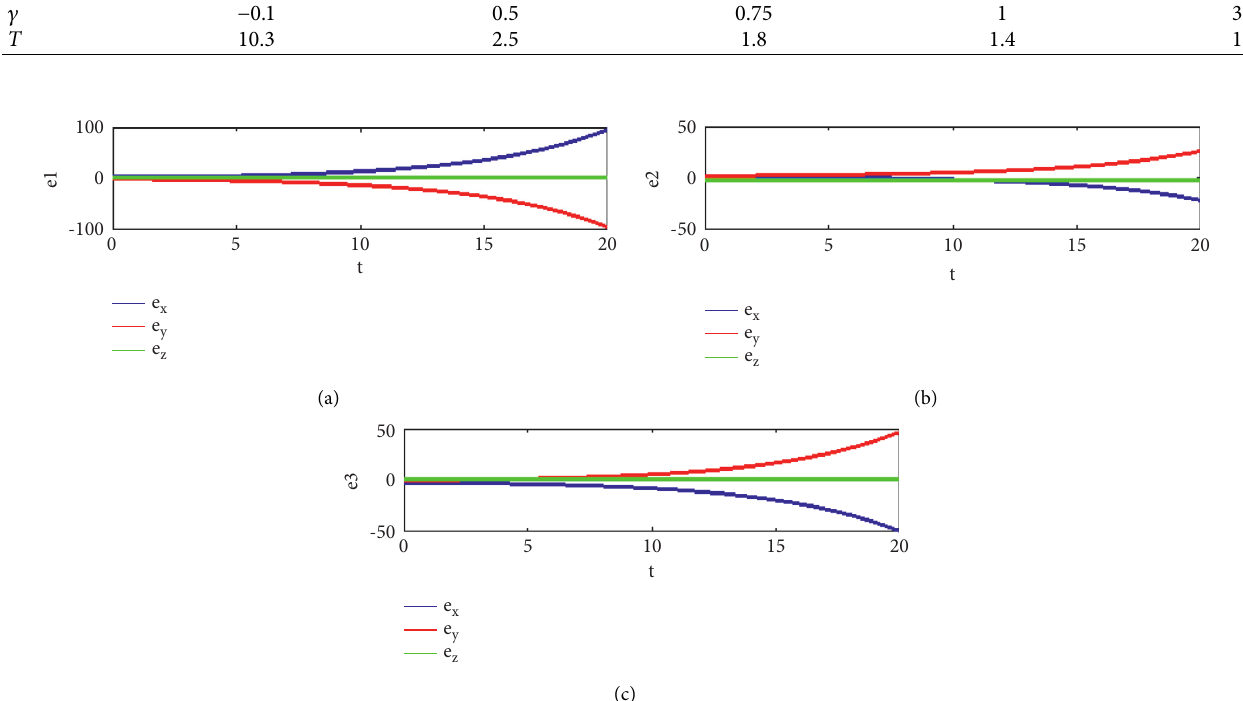
Figure 4: The error trajectories of leader and agents with c � − 0 . 3 in Example 1. (a) The error trajectories of v0 and v1. (b) The error trajectories of v0 and v2. (c) The error trajectories of v0 and